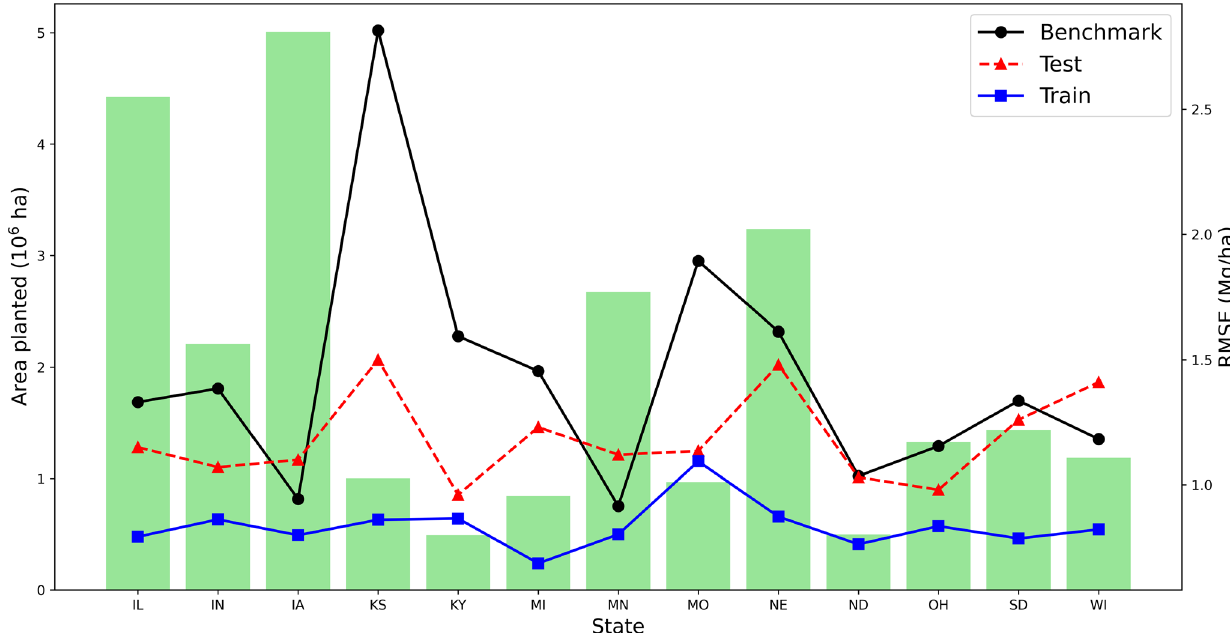
Fig. 3 Spatial extrapolation results. Green bars are average planted areas from 1981 to 2020. The three curves represent the benchmark nearest-county approach on the test data, and the data-driven crop model on test data and training